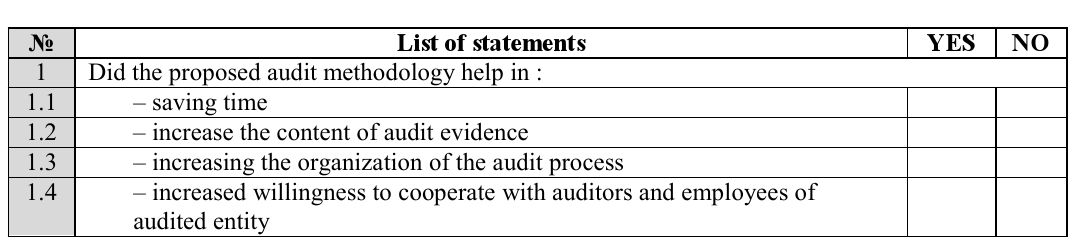
Fig. 3. Fragment of the questionnaire used in the